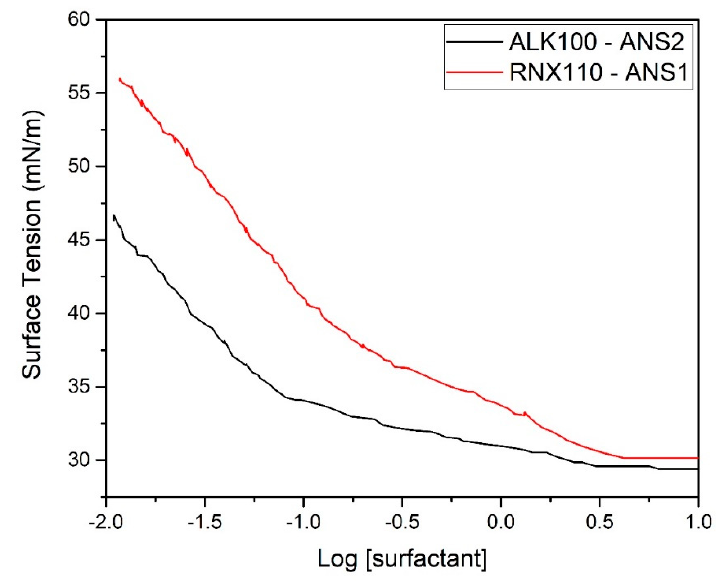
Figure 6. Plots of surface tension versus surfactant concentration.